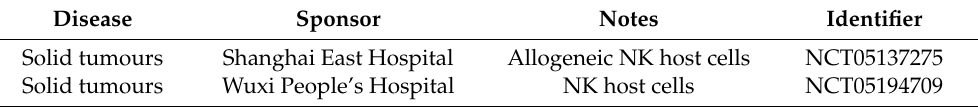
Table 5. Ongoing CAR T-cell clinical trials directed against 5T4 (accessed on 12 January 2023). Disease Sponsor Notes